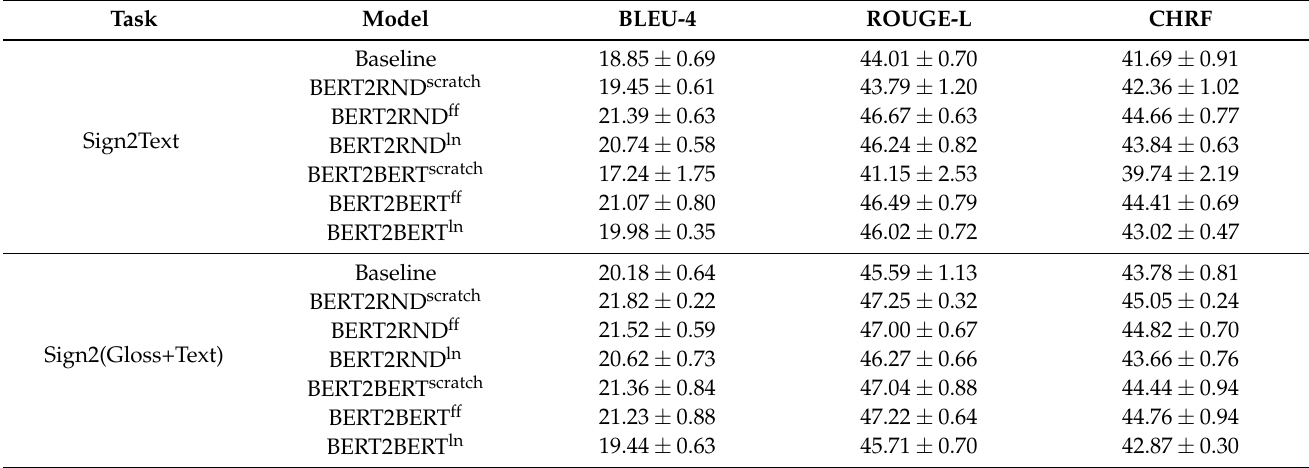
Table 2. Overview of the scores on the test set for the different models, averaged over five trials with different random